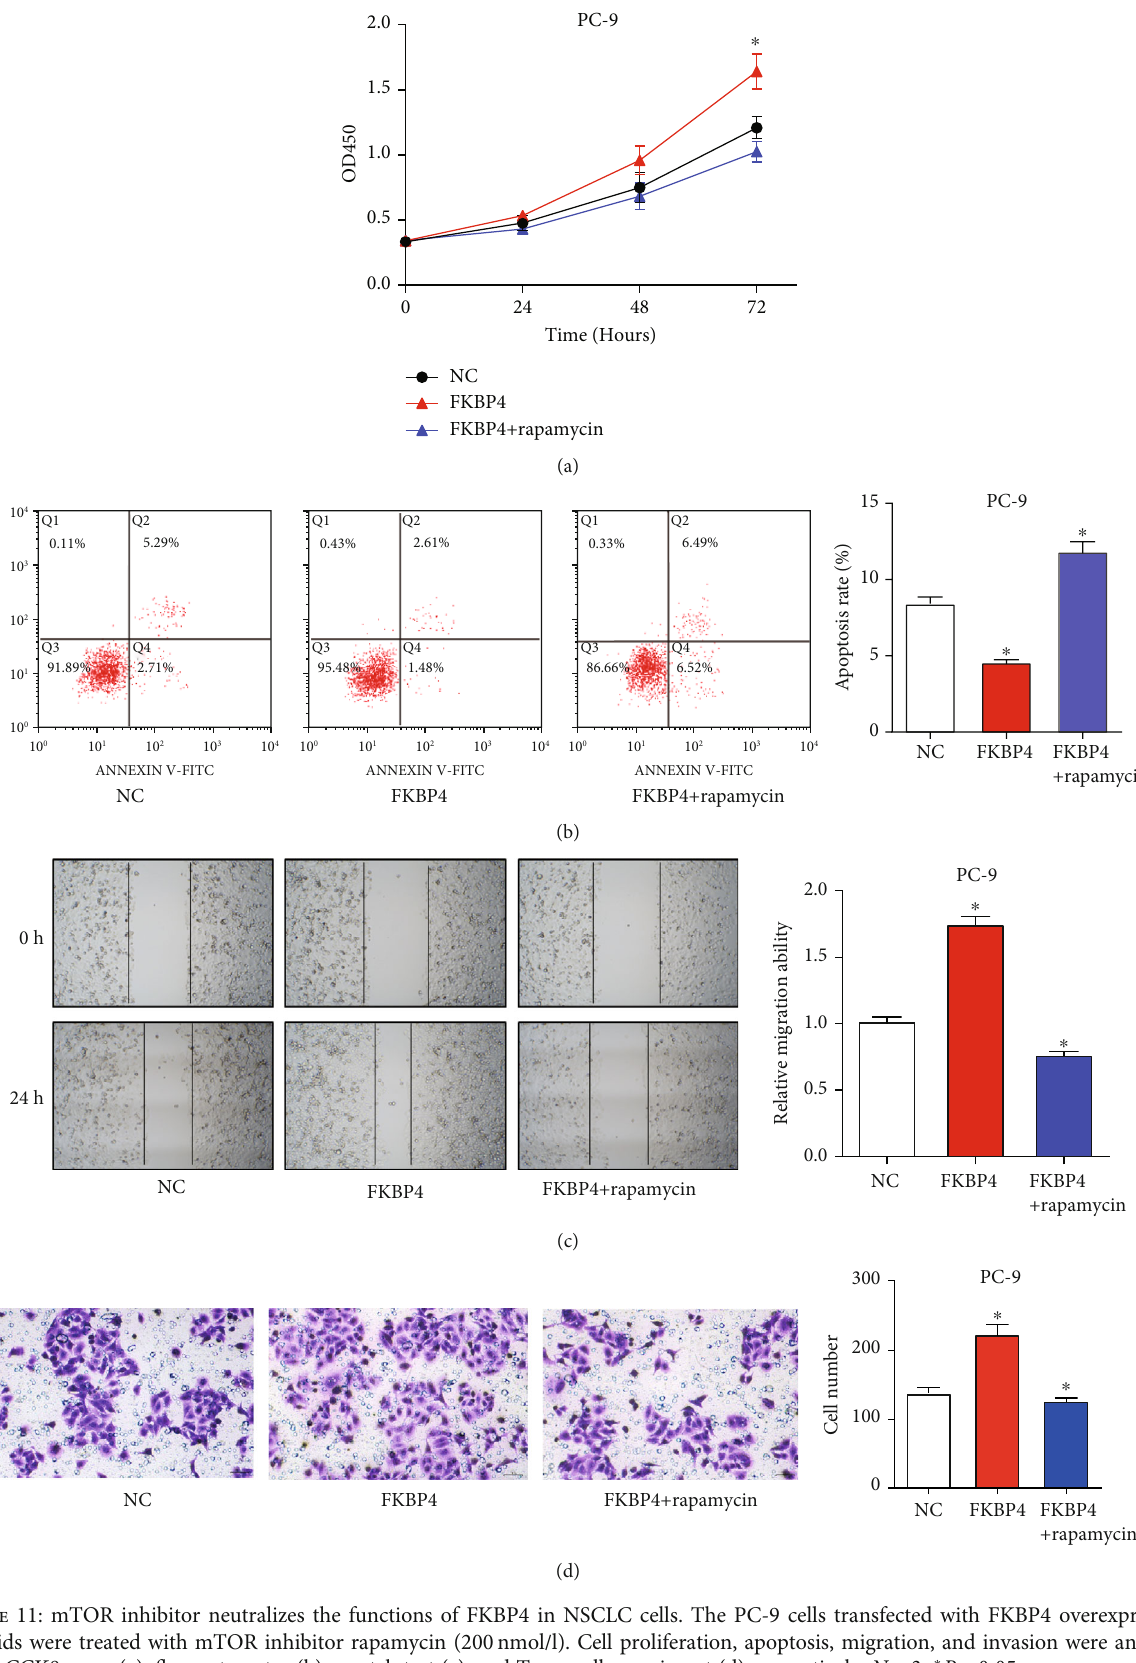
Figure 11: mTOR inhibitor neutralizes the functions of FKBP4 in NSCLC cells. The PC-9 cells transfected with FKBP4 overexpression plasmids were treated with mTOR inhibitor rapamycin (200nmol/l). Cell proliferation, apoptosis, migration, and invasion were analyzed by the CCK8 assay (a), fl ow cytometry (b), scratch test (c), and Transwell experiment (d), respectively; N = 3 , ∗ P < 0 : 05